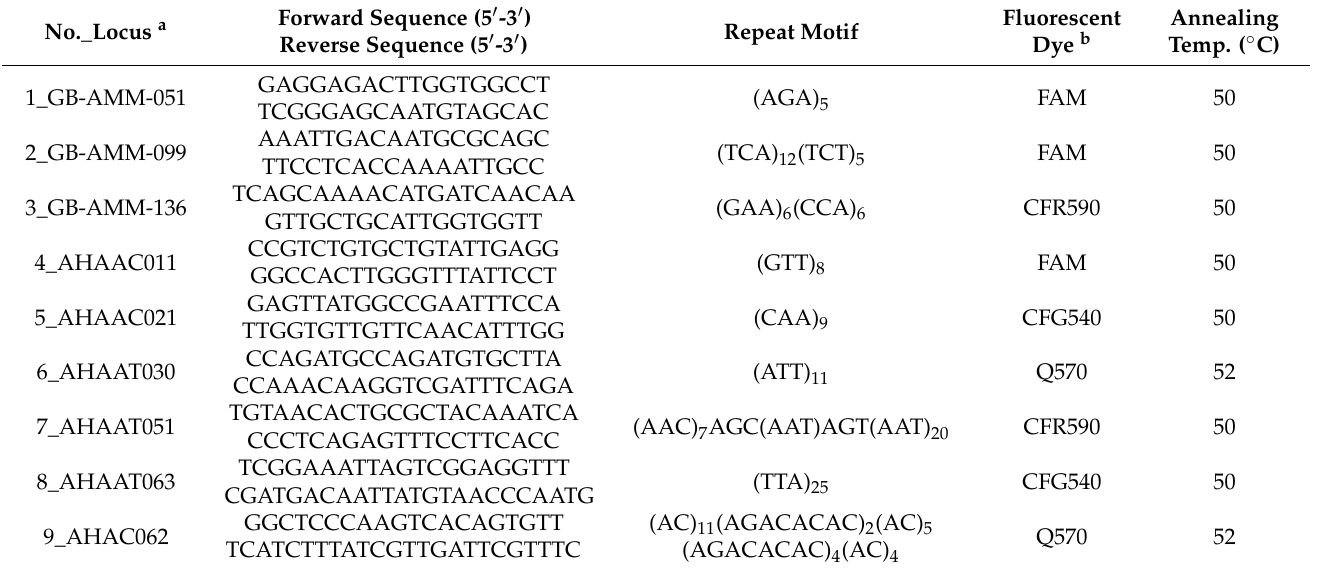
Table 1. Primer sequences, repeat motifs, florescent dyes used to label the forward primer and annealing temperatures for nine selected SSR loci used for molecular characterization of the black amaranth